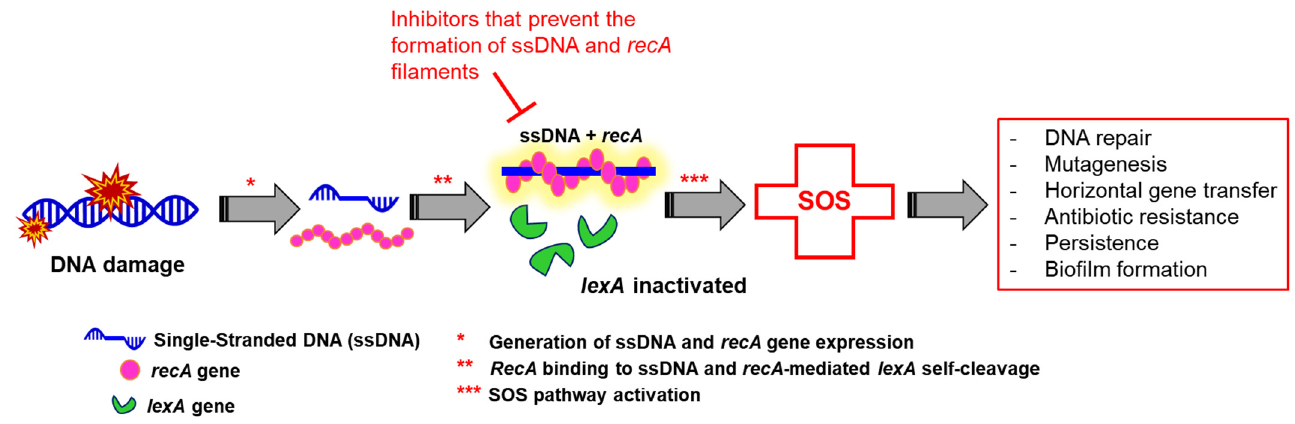
Figure 4. Bacterial SOS response pathway.